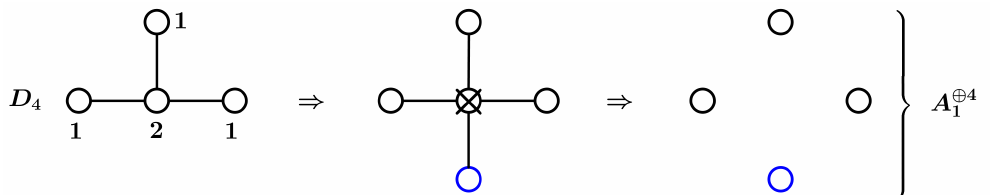
subalgebra of D 1